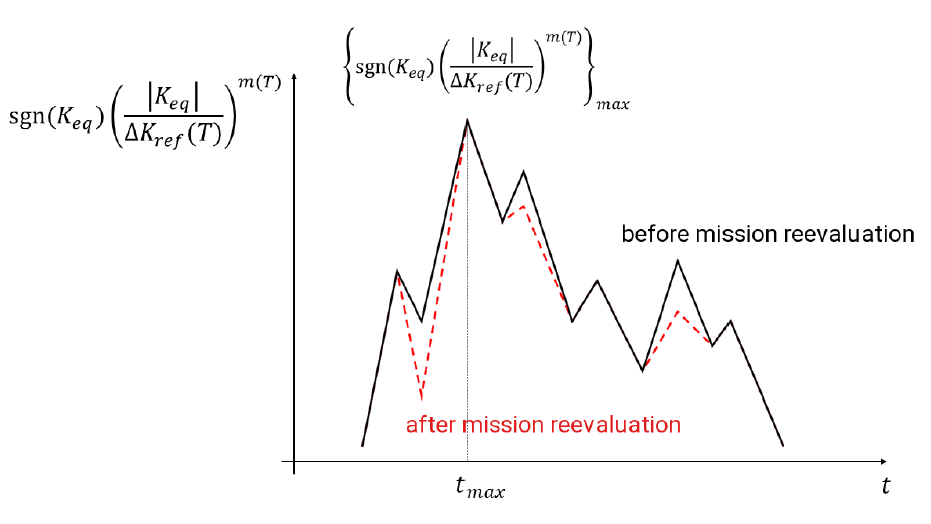
Figure 8. Crack growth rate evolution over time. The continuous black lines represent the crack growth rate for the given mission. The red dashed lines represent the crack growth rate after the mission